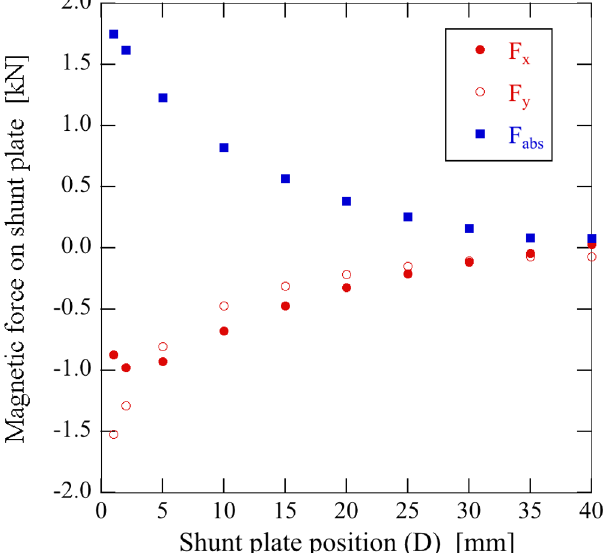
8. Simulated magnetic forces acting on a tuning shunt